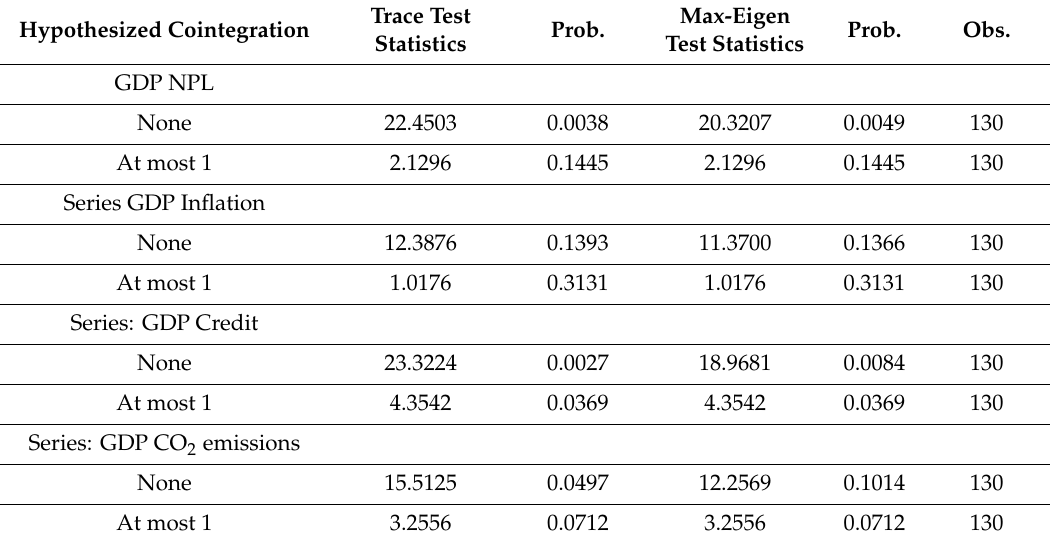
Table 9. Individual cross-section results—India.